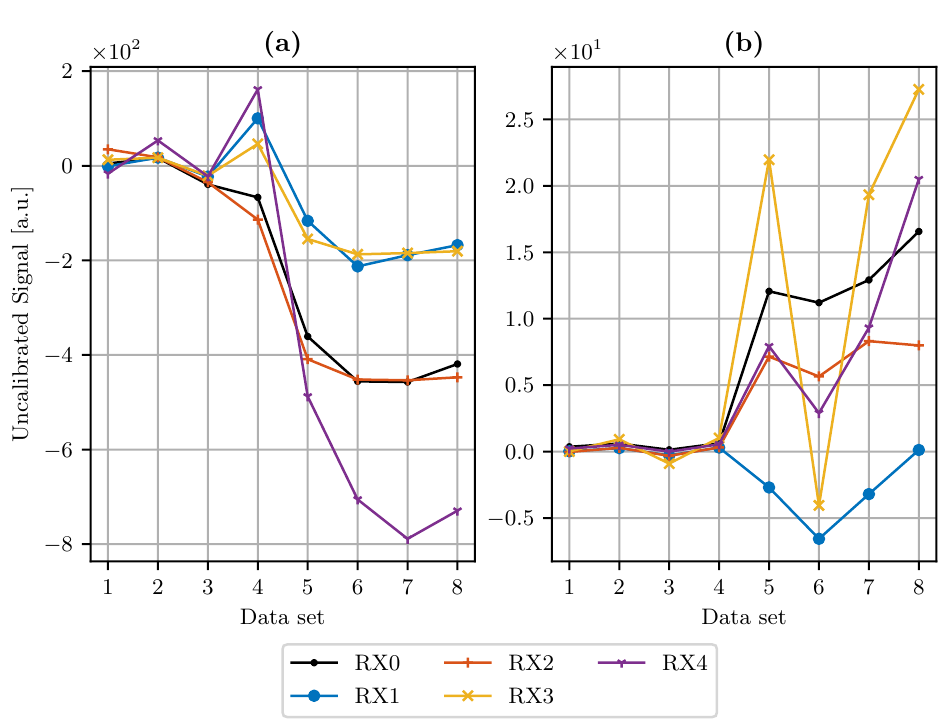
Figure 4. Sensor signal offset of all data sets without drift compensation applied ( a ) and with drift compensation applied ( b ).